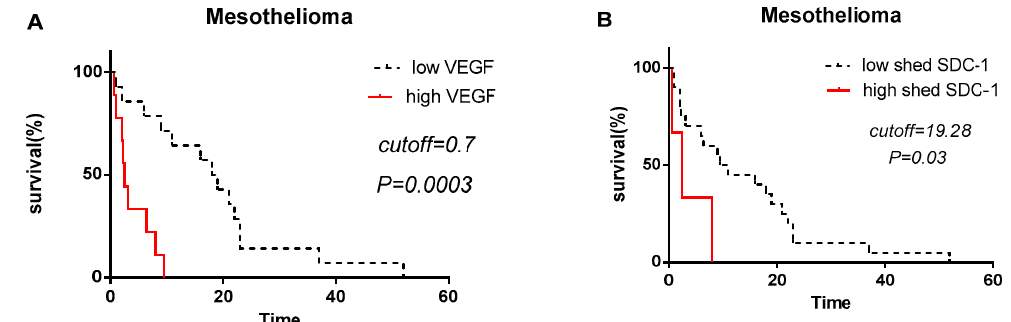
Figure 4. VEGF and shed SDC-1 have prognostic value in malignant mesothelioma patients. Patients were separated into “high” and “low” VEGF and shed SDC-1 level by the online web application Cutoff Finder (VEGF cutoff = 0.7 ng/mL and shed SDC-1 = 19.28 ng/mL). Malignant mesothelioma patients with high level of VEGF ( A ) and shed SDC-1 ( B ) have shorter survival time compared to malignant mesothelioma patients with low VEGF and shed SDC-1 levels. P- values are ≤ 0.05.